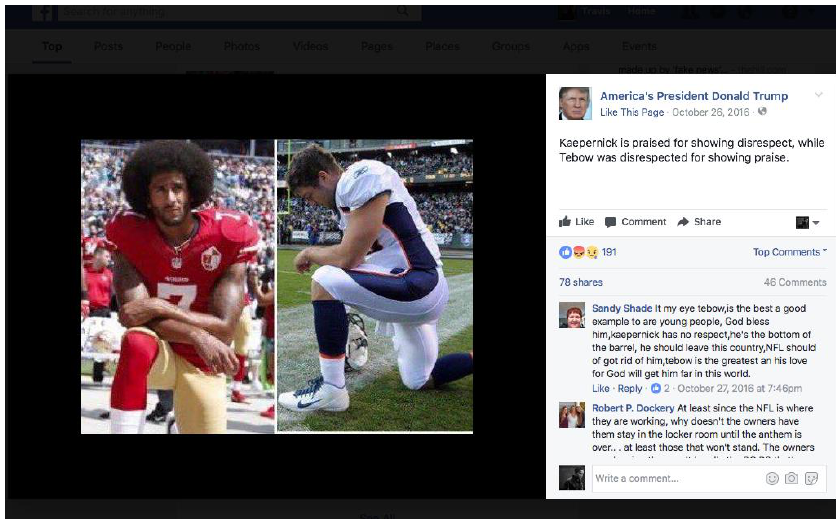
FIGURE 1. THIS IMAGE IS A SCREEN SHOT FROM A POST ON U.S. PRESIDENT DONALD TRUMP’S PAGE THAT SOUGHT TO VILIFY KAEPERNICK AND IMPLY TIM TEBOW AS A GREAT WHITE